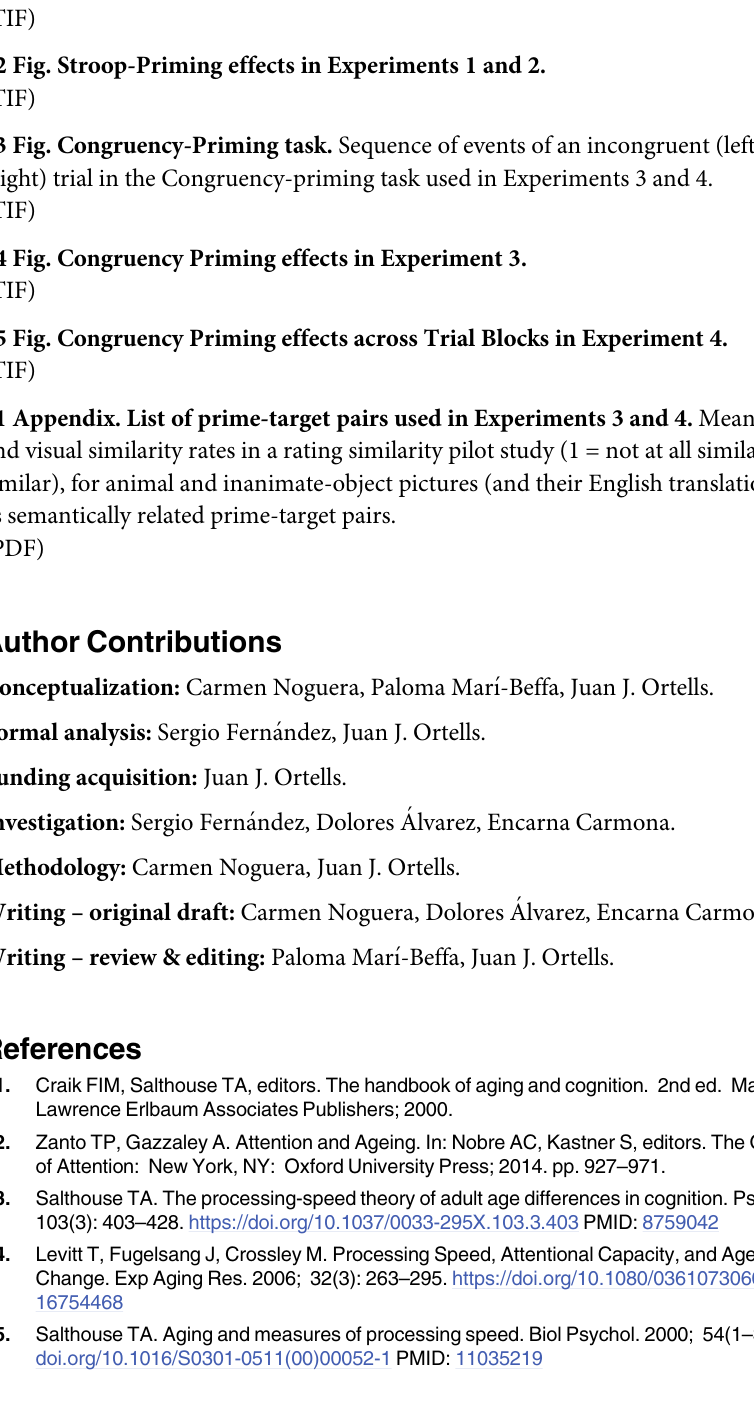
S1 Fig. Stroop-Priming task. Examples of incongruent (left) and congruent (right) trials used in Experiments 1 and 2. S2 Fig. Stroop-Priming effects in Experiments 1 and 2. S3 Fig. Congruency-Priming task. Sequence of events of an incongruent (left) and congruent (right) trial in the Congruency-priming task used in Experiments 3 and 4. S4 Fig. Congruency Priming effects in Experiment 3. S5 Fig. Congruency Priming effects across Trial Blocks in Experiment 4. S1 Appendix. List of prime-target pairs used in Experiments 3 and 4. Mean (SD) functional and visual similarity rates in a rating similarity pilot study (1 = not at all similar; 7 = highly similar), for animal and inanimate-object pictures (and their English translations), presented as semantically related prime-target